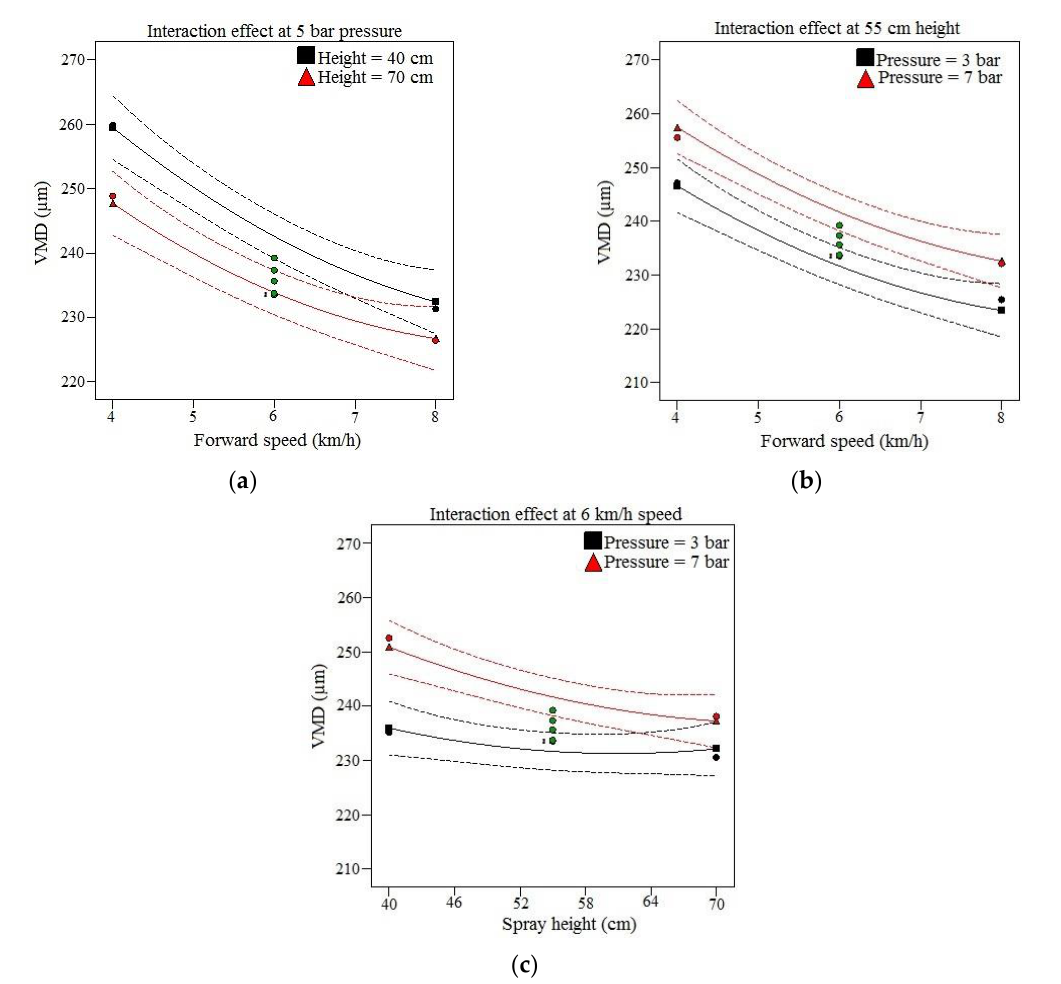
Figure 9. VMD: (a ) Relationship between forward speed and spray height at 5 bar pressure; ( b ) Relationship between forward speed and pressure at 55 cm spray height; ( c ) relationship between spray height and pressure at 6 km/h speed.